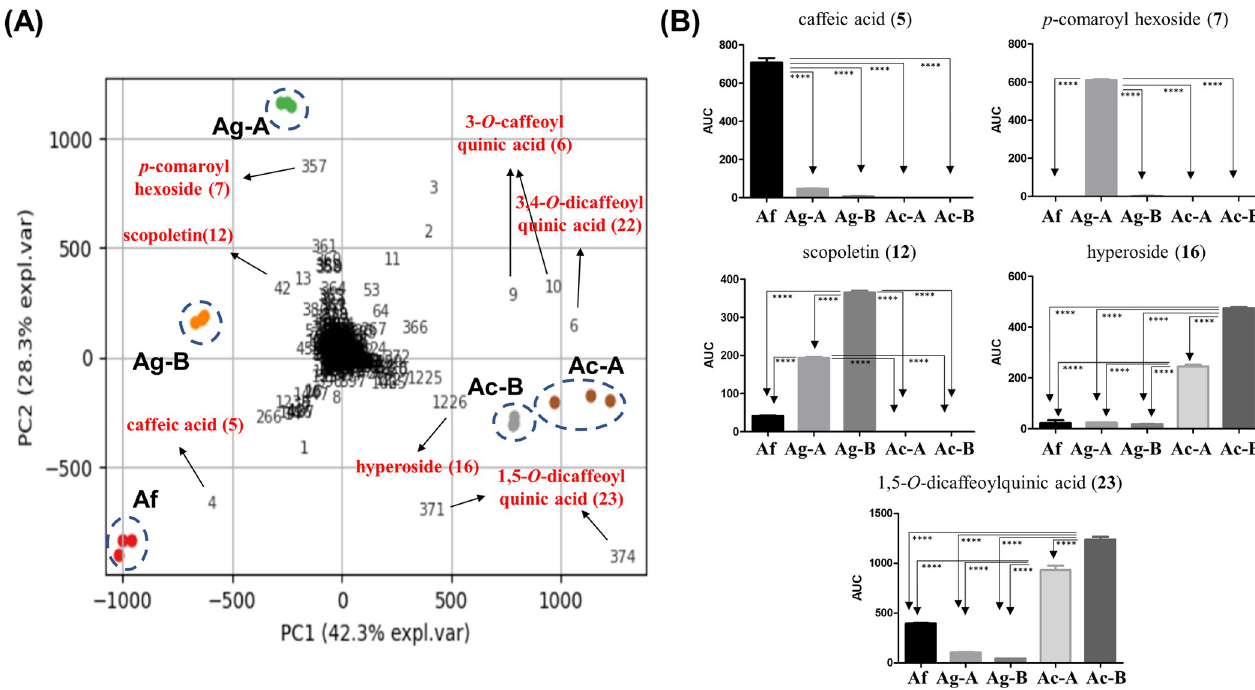
Fig 6. (A) The PCA biplot of the Artemisia samples represented by group marks (Af: A . fukudo ; Ag-A: A . gmelinii -A; Ag-B: A . gmelinii -B; Ac-A: A . capillaris - A; Ac-B: A . capillaris -B). The numbers denote PCA loadings of each MS feature. Important marker MS features are labeled with their annotation and peak numbers enlisted in Table 3. Most MS features shown here are [M − H] − ions, but MS features 9 and 372 are in-source fragments of peaks 6 and 23 , respectively. (B) Bar plots showing the ion intensities of selected marker peaks ( 5 , 7 , 12 , 16, and 23 ) in analyzed Artemisia samples ( ���� p < 0.0001).